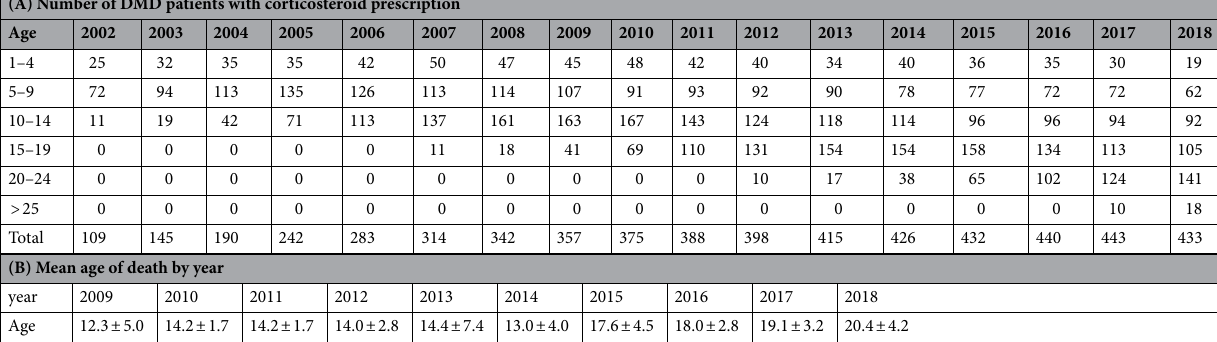
Table 1. Number of DMD patients with corticosteroid prescription and age of death by